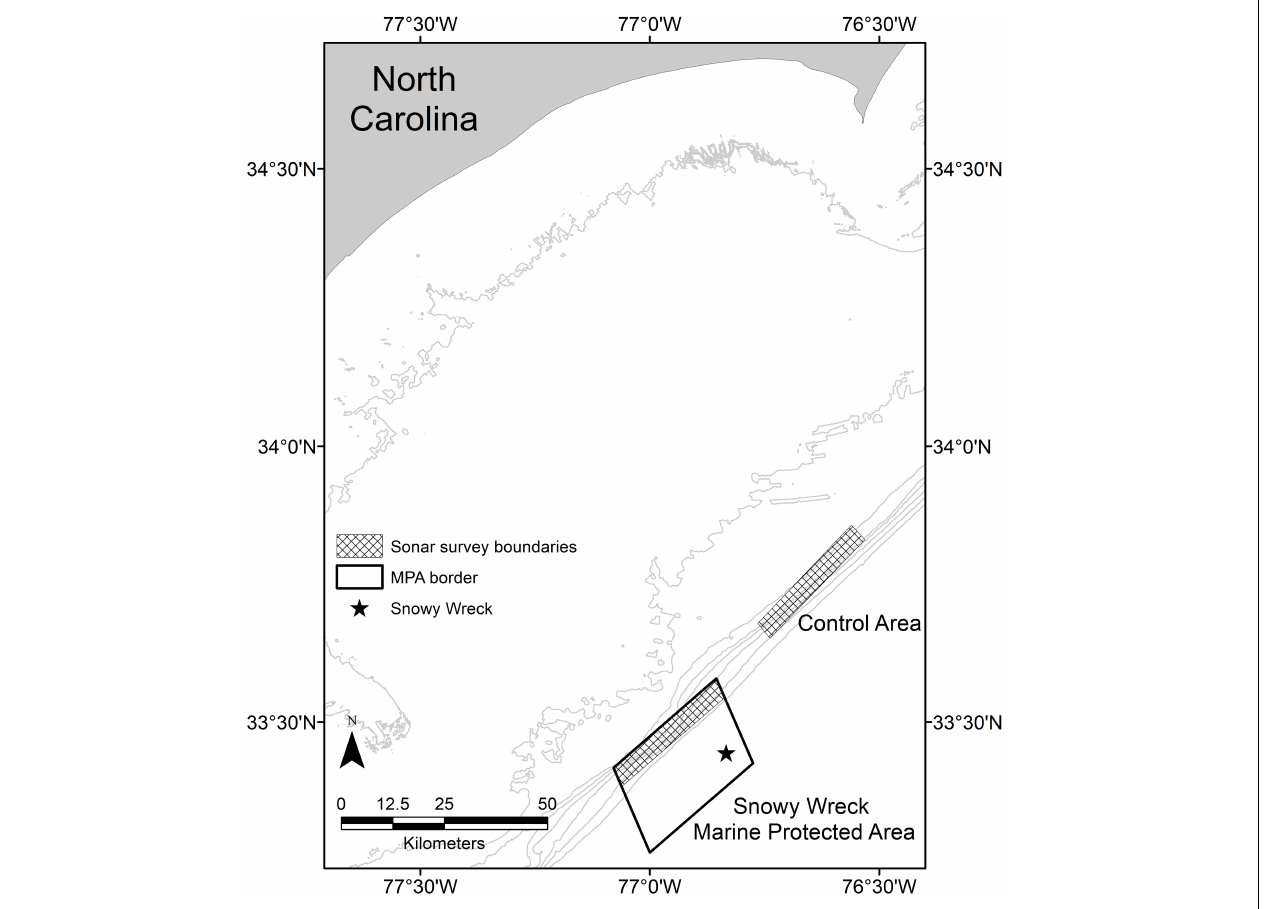
FIGURE 1 | Map of the central North Carolina (United States) coastline. Checkered boxes delineate the survey extent within the Snowy Wreck Marine Protected Area and the control area for the present study and from Rudershausen et al. (2010). The Snowy Wreck location is indicated with a star. Gray contour lines represent 20, 40, 60, 80, 100, 120, 140, and 160 m